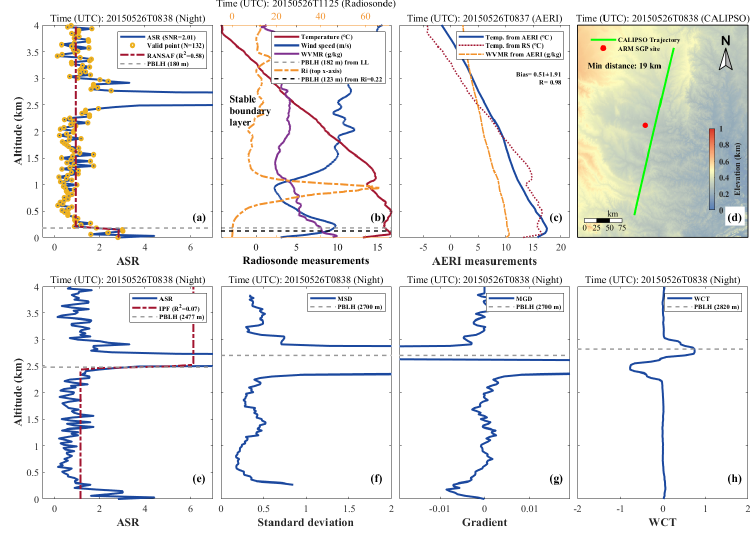
Figure 5. ASR was measured by CALIOP at 08:38:40 UTC (night) on 26 May 2015; PBLHs were determined with the ( a ) RANSAF, ( b ) radiosonde (RS), ( e ) IPF, ( f ) MSD, ( g ) MGD, and ( h ) WCT methods; ( c ) vertical profile of temperature and water vapor mixing ratio (WVMR) retrieved from AERI with the red dotted line referring to temperature measured by RS in ( b ), Bias (R) is the mean di ff erence (correlation coe ffi cient) between temperature profiles from AERI and RS; ( d ) ARM SGP site of radiosonde observations and CALIPSO trajectory. The minimum distance between the CALIOP and radiosonde (AERI) measurements are shown at the top of subfigure ( d